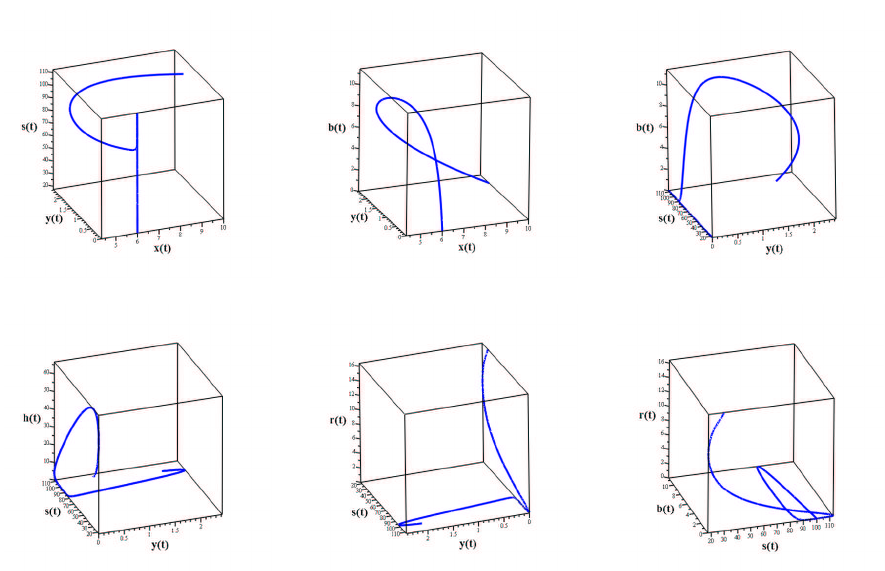
Figure 12: Phase portraits using 5-term MsDTM with r 0 = 0.9 and R 0 ≈ 7.1